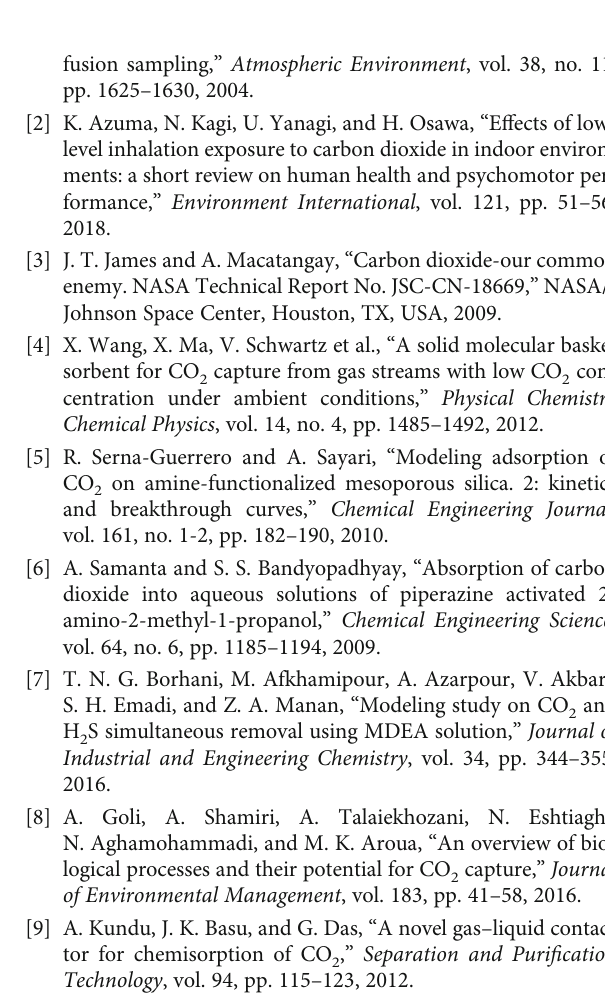
capture determined by TGA. At the end of each run, the sorbent was regenerated by 2 was detected in the exhaust 2